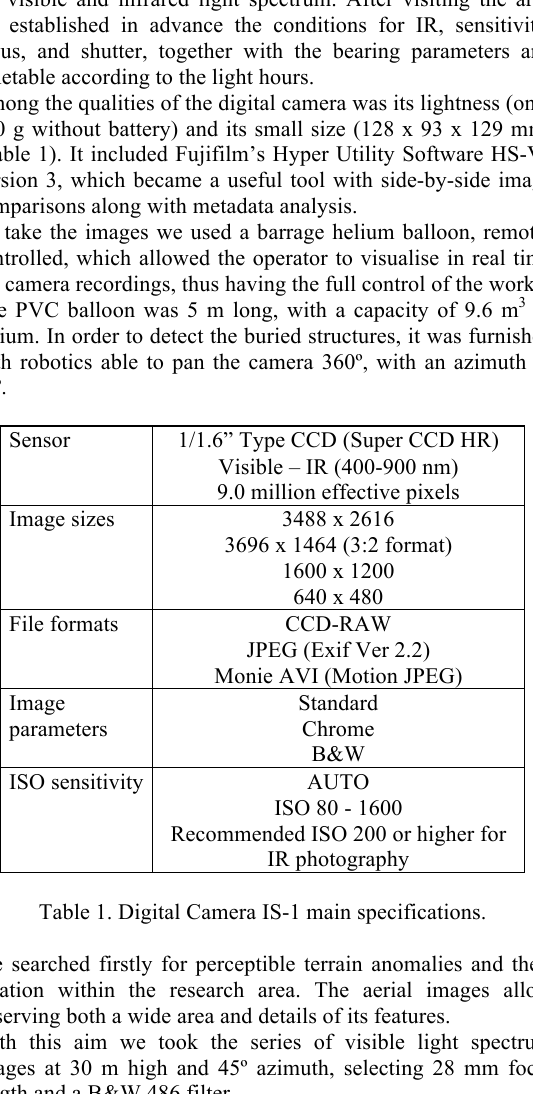
Figure 5. Topographic map of the Monastery of El Escorial and its surroundings; the circle defines the research area.